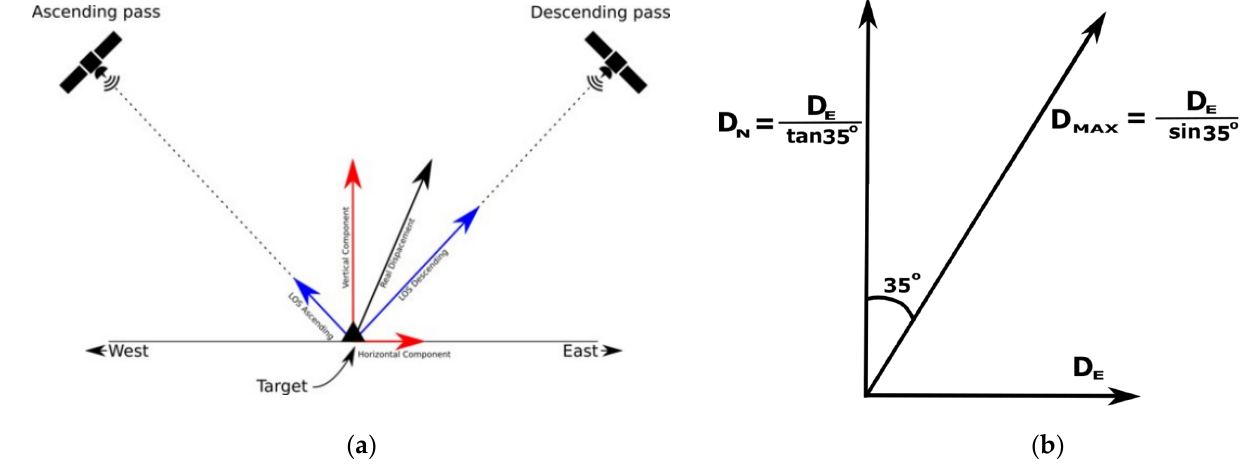
Figure 4. The estimation of horizontal displacement components: ( a ) eastward (D E ) through the decomposition of ascending and descending orbit direction data [45] and ( b ) northward (D N ) and maximum displacement (D MAX ) along N35 ° E based on the measured eastward displacement (D E ).